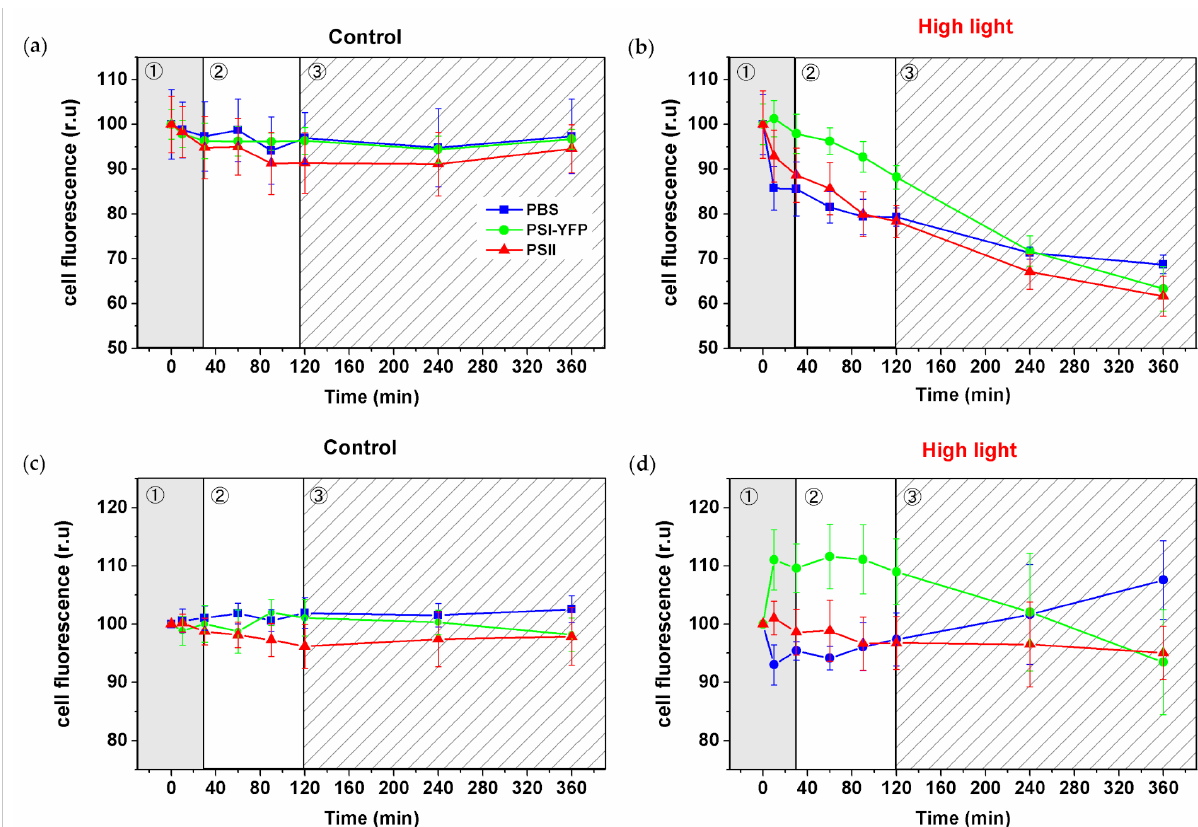
Figure 3. High-light induced changes in PSI-YFP, PSII, and PBS fluorescence emission detected from the single cells of Synechocystis PSI - YFP . Single-cell fluorescence intensities were calculated from three channels’ confocal images (see, e.g., Figure 2) acquired at particular time spots during HL treatments. Panels ( a ) and ( b ) represent normalized fluorescence changes of single-cell PSII, PSI-YFP, and PBS emission for control ( a ) and HL treated sample ( b ). Data were normalized to